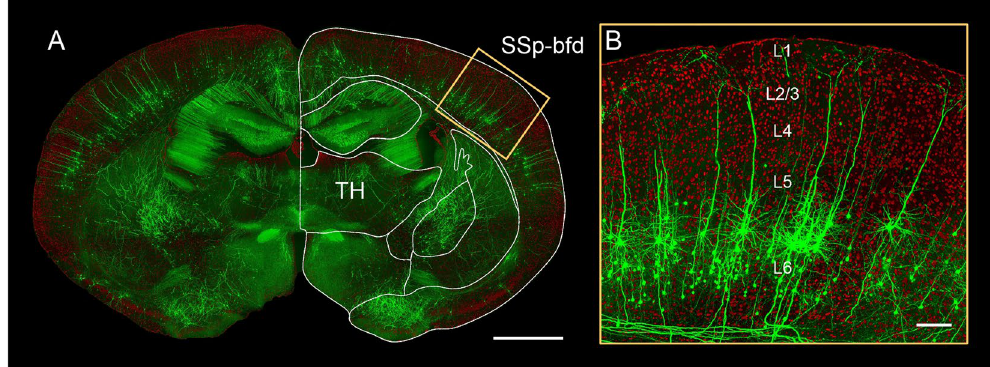
Figure 1. Location of the barrel field and the local morphology of the pyramidal neurons. ( A ) The merged image of the GFP-channel (green, thickness of projection: 300 μ m) and the PI-channel (red, thickness of projection: 2 μ m). The superimposed outline is used for brain area localization. SSp-bfd indicates barrel-related primary somatosensory cortex. TH represents the thalamus. Scale Bar = 1 mm. ( B ) Enlarged view of the yellow bounding box in ( A ) with rotation, which illustrates the cortical cytoarchitecture and the fine morphology of pyramidal neurons. Scale Bar = 100 μ